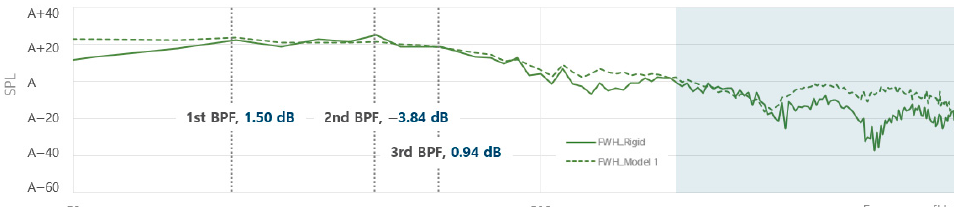
Figure 15. Sound pressure level of rigid and composite propellers (model 1) in the cavitating flow.